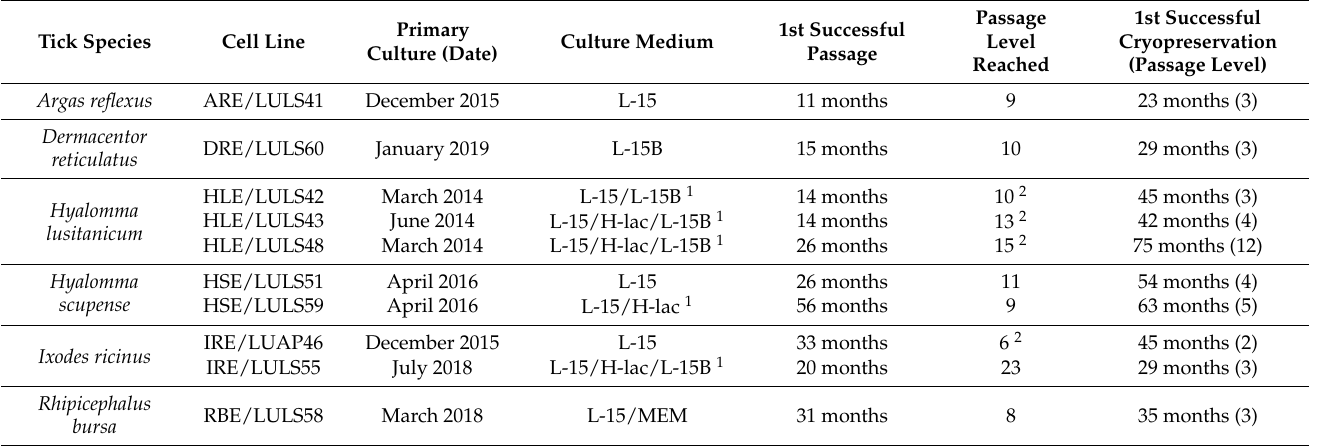
Table 2. Summary of new tick cell lines generated from European tick species in the present